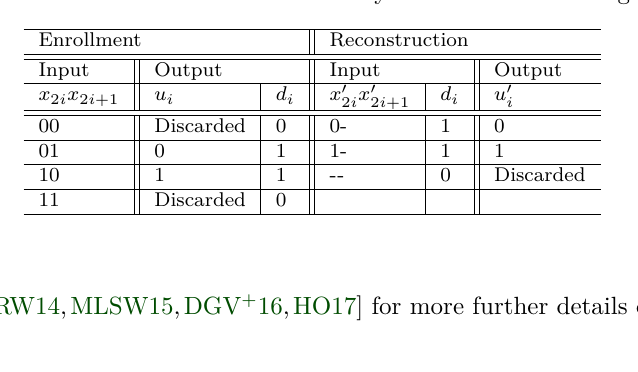
Table 2: Debiased bit extraction by VNC-based